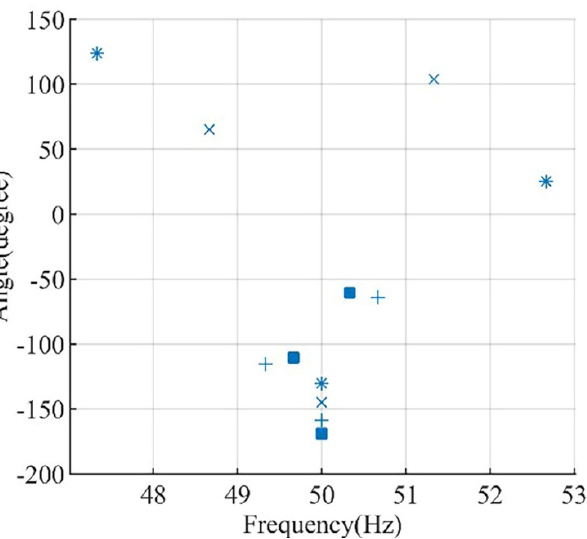
Figure 7. Motor I phase angle of left sideband, right sideband and fundamental components for healthy conditions at; 10% loading ( ■ ), 25% (+), 50% loading (×), and full loading (*).